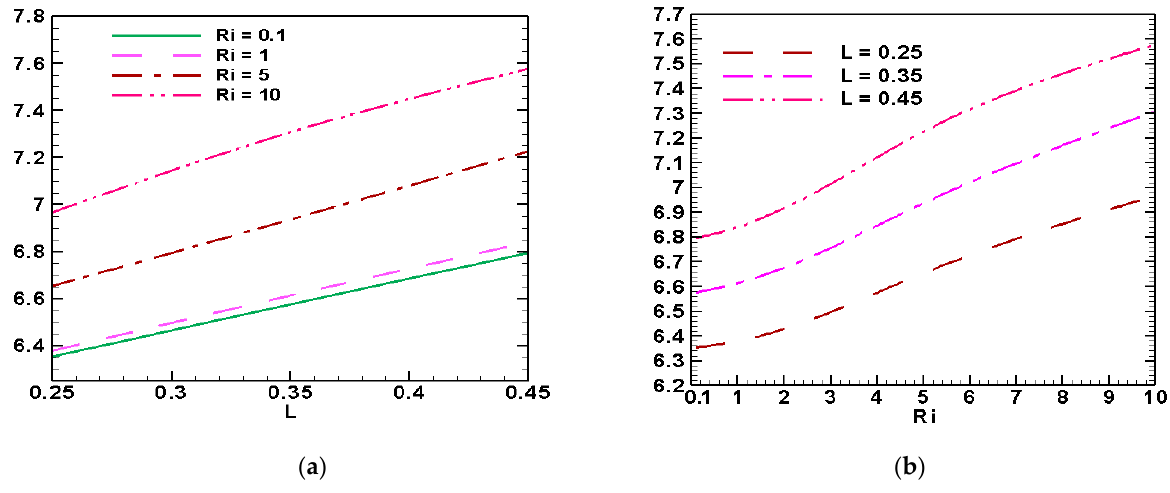
Figure 8. Nu av for ( a ) several Ri (0.1, 1, 5, and 10) and ( b ) various L (0.25, 0.35, 0.45) at Ha = 20 and Re = 100.